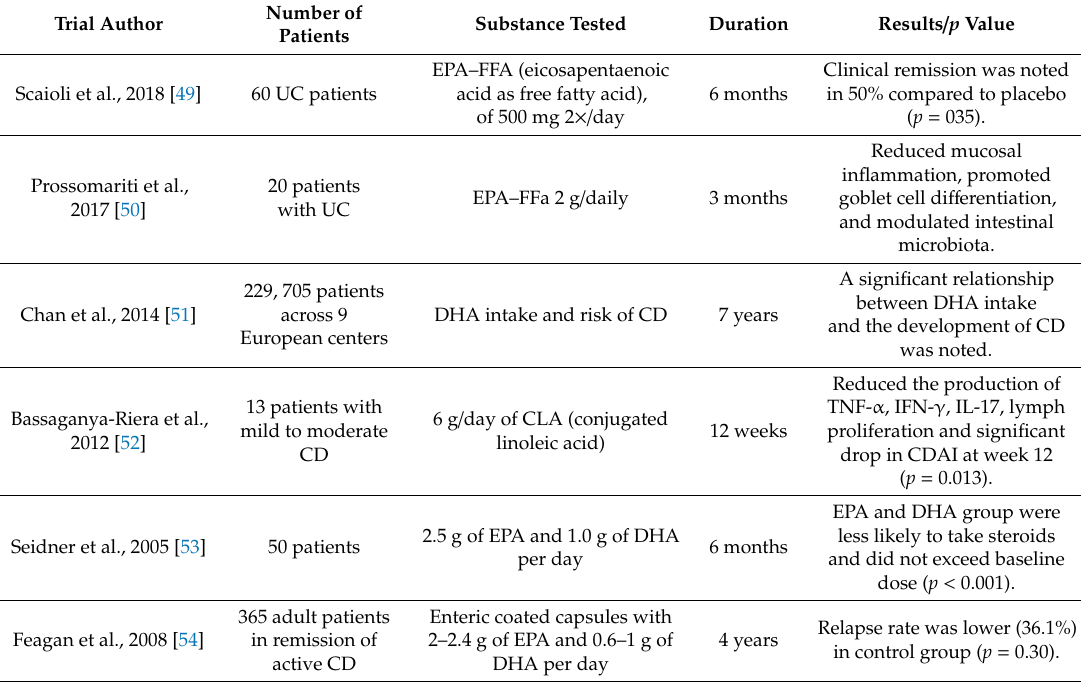
Table 4. Summary of trials examined for e ff ectiveness of Fatty Acids on